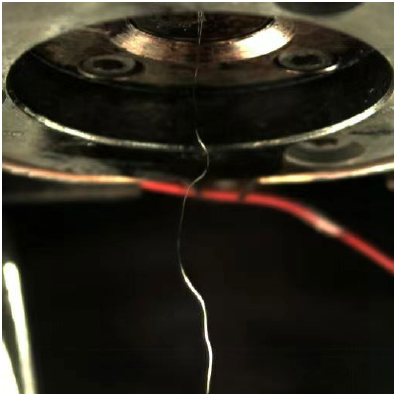
Figure 2. Whip trajectory of the melt-blown fiber under the following experimental conditions: air pressure—50,000 Pa, flow rate of polypropylene—7.8 cc/min, exposure frequency—5000 fps.